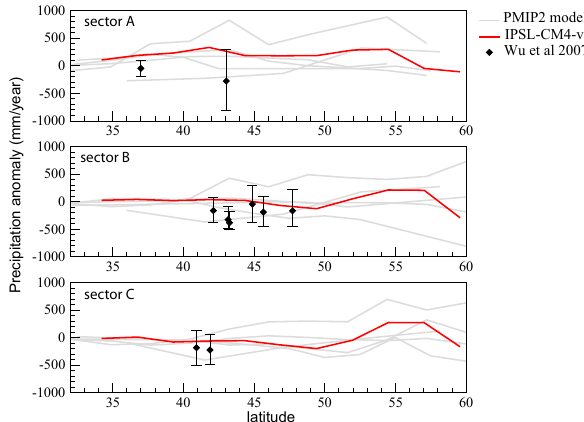
Fig. 6. Difference in annual precipitation (mmyr − 1 ) between the LGM and present-day simulated by IPSL CM4 (red) and other GCM from the PMIP2 project (grey), for 3 longitude bands over Western Europe, between 32 ◦ and 60 ◦ N. The limits of the three sectors are plotted in Fig. 8. Sector A: lon= − 15/ − 2 ◦ , Sector B: lon= − 2/10 ◦ , Sector C: lon=10/20 ◦ . Black diamonds are precipi- tation values reconstructed by Wu et al. (2007) with the associated uncertainty